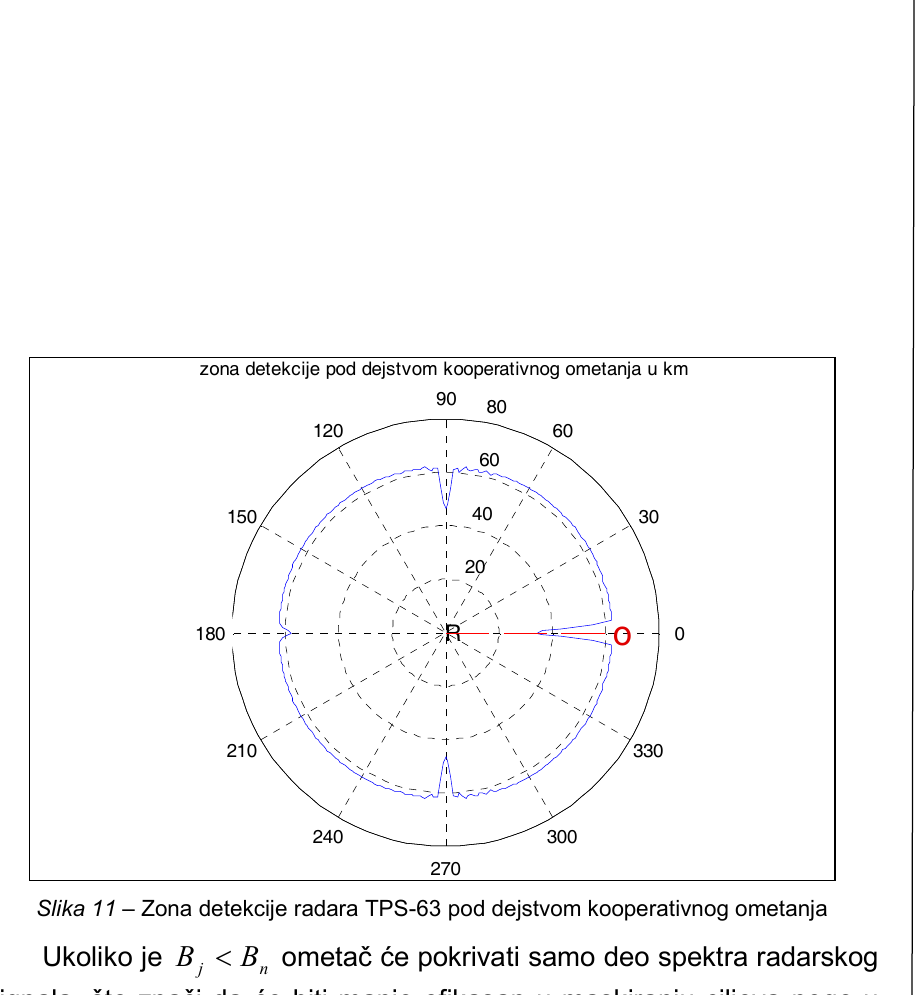
slu č aju kada je širina spektra signala ometa č a jednaka širini spektra kori- snog signala. Podrazumeva se da je propusni opseg prijemnika podešen na širinu spektra korisnog signala.